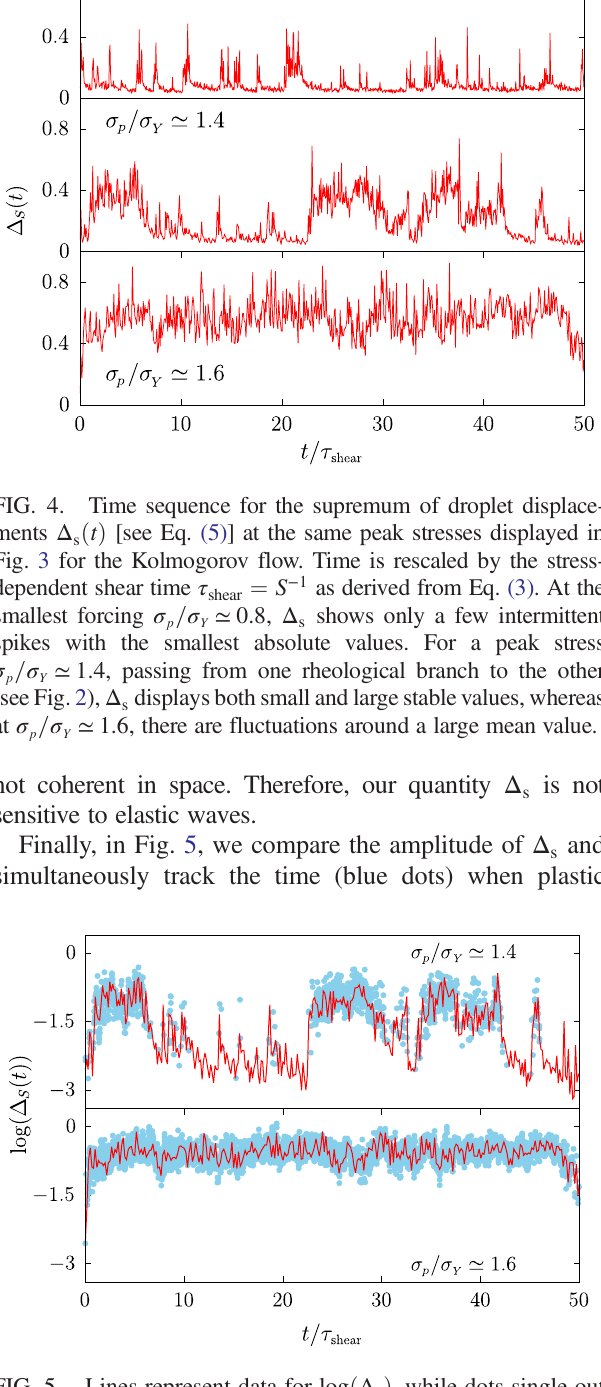
FIG. 5. Lines represent data for log ð Δ values concurrent with plastic rearrangements. Time is rescaled by the stress-dependent shear time τ Eq. (3). Two different regimes are displayed. Top panel: σ = σ ≃ 1 . 4 , the system spends roughly half of the time in an p Y elastic solid state and the other half in a plastic fluidized state where the plastic rearrangements cluster. Bottom panel: σ = σ ≃ 1 . 6 , the system is in a fluidized state and plastic p Y rearrangements are homogeneously